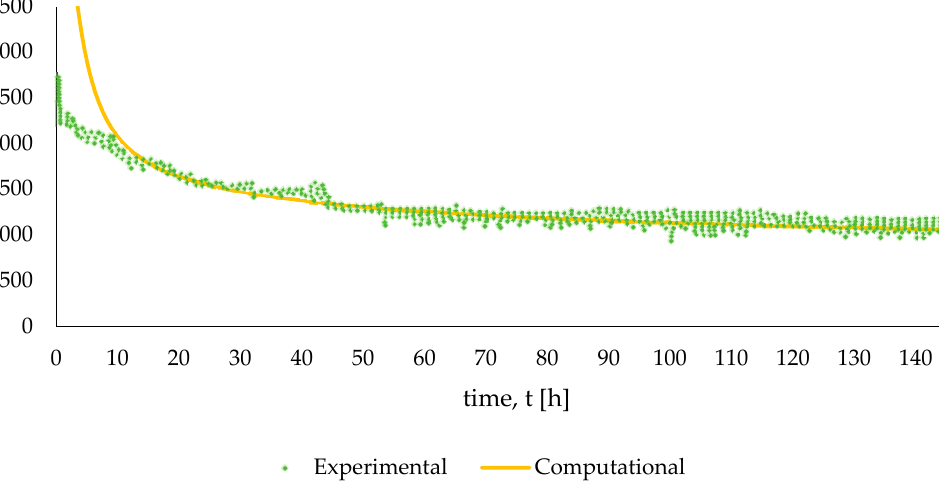
Figure 6. Experimental validation of computational model for a spiral GHE.